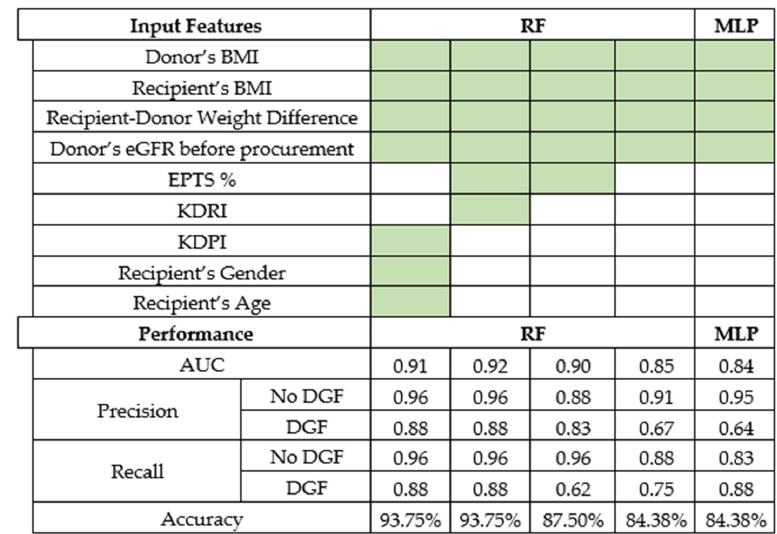
Figure 2. Various sets of input features and their performance statistics: all top models needed a database of 4 variables: donor’s BMI, recipient’s BMI, recipient–donor weight difference, and donor’s eGFR before procurement. A colored cell means that the variable from the input features column was used by the RF or MLP model. Precision and recall were measured separately for each class: DGF occurrences or no DGF. Some models needed additional variables, as shown in the table. More or fewer variables influenced the